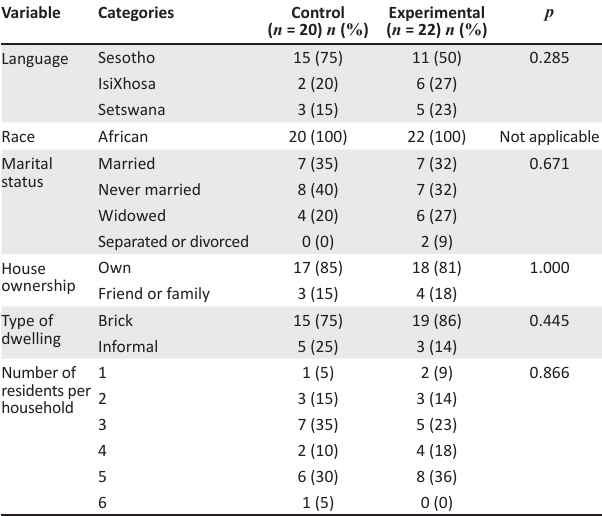
TABLE 1: Comparison of the demographic characteristics of the two groups ( n =